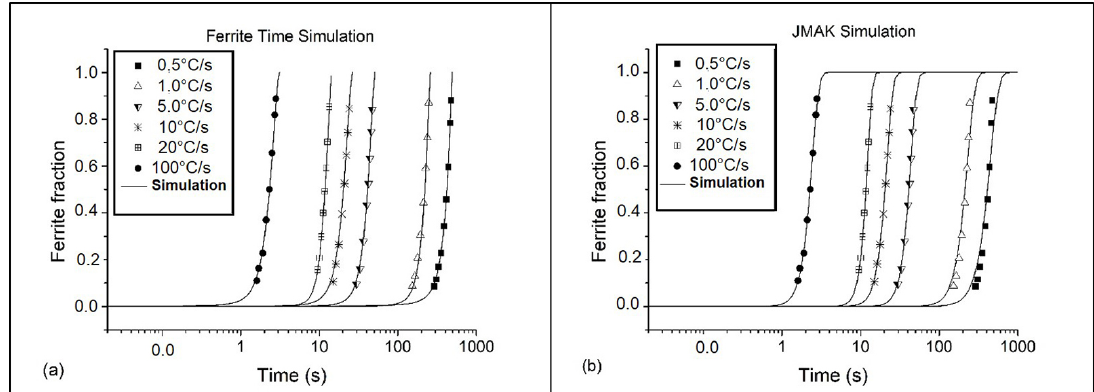
Figure 7. Simulation of ferrite formation kinetics for IF-Ti steel considering (a) Ferrite-Time Model and (b) JMAK Model.